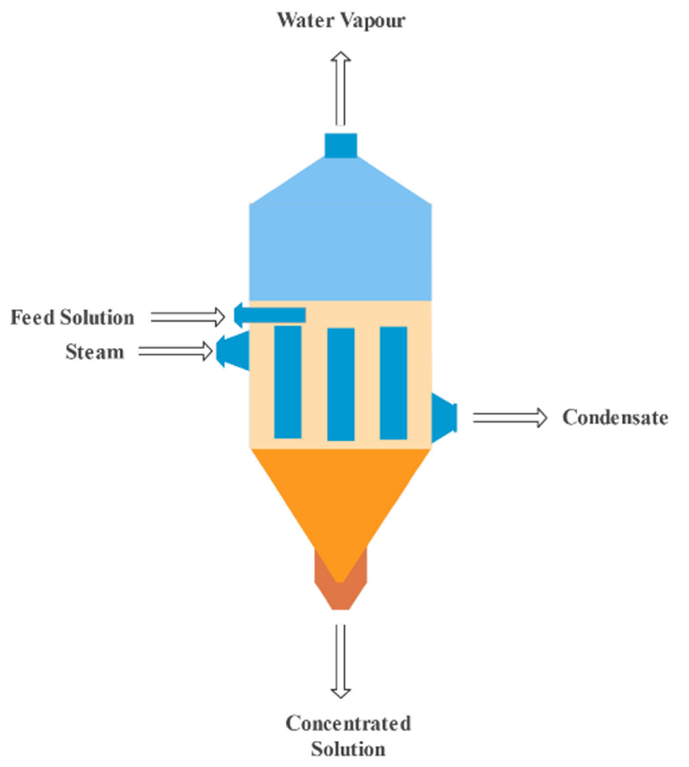
Figure 1. Evaporation technique [71] .